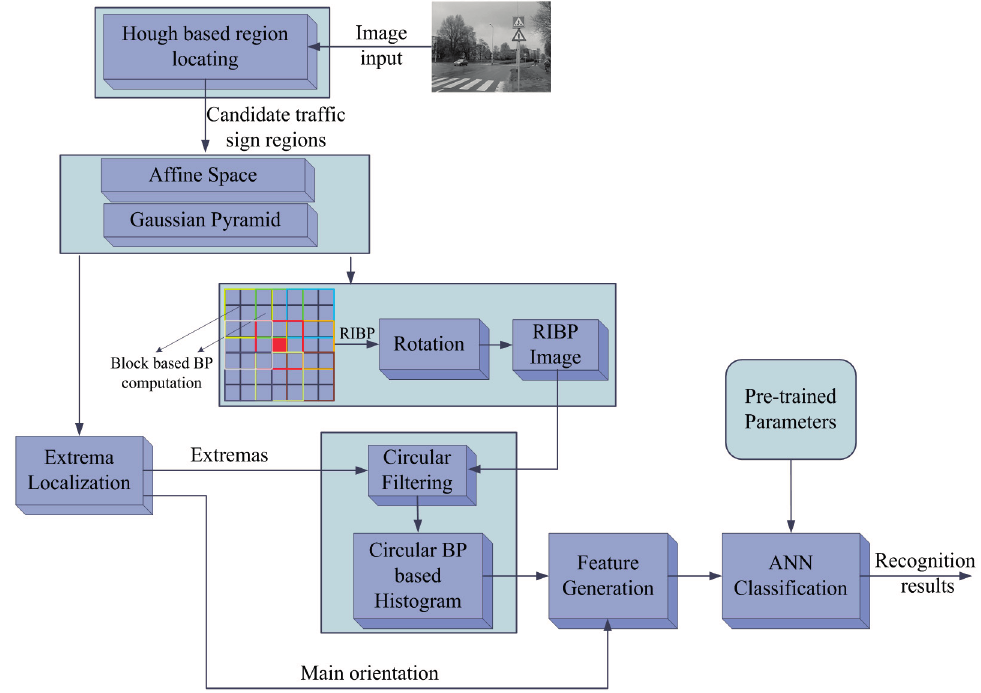
Figure 5. The whole computation flow of traffic sign recognition. The image embedded in the graph is from the GTSRB data